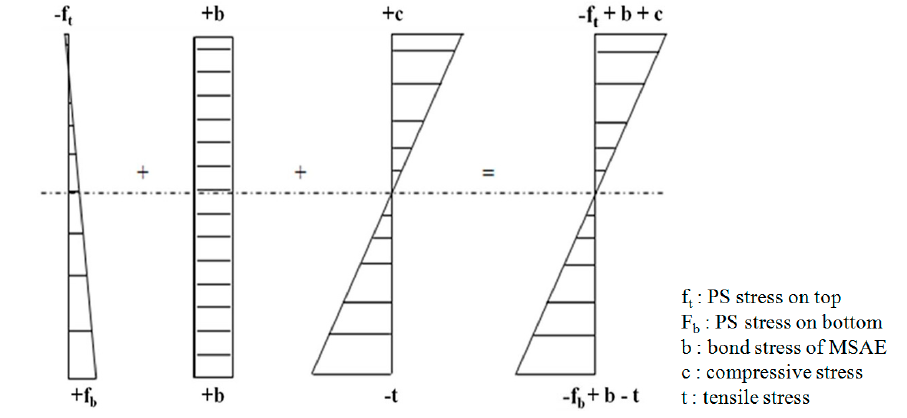
Figure 21. Stress diagram at interface.